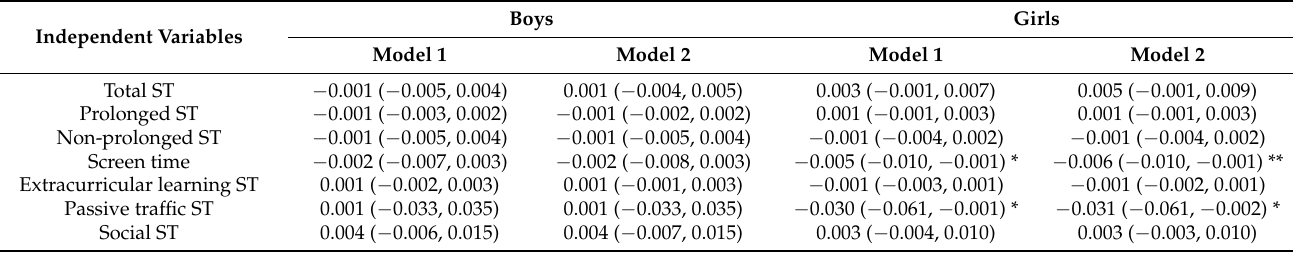
Table 4. Associations between ST and CRF in children and adolescents.